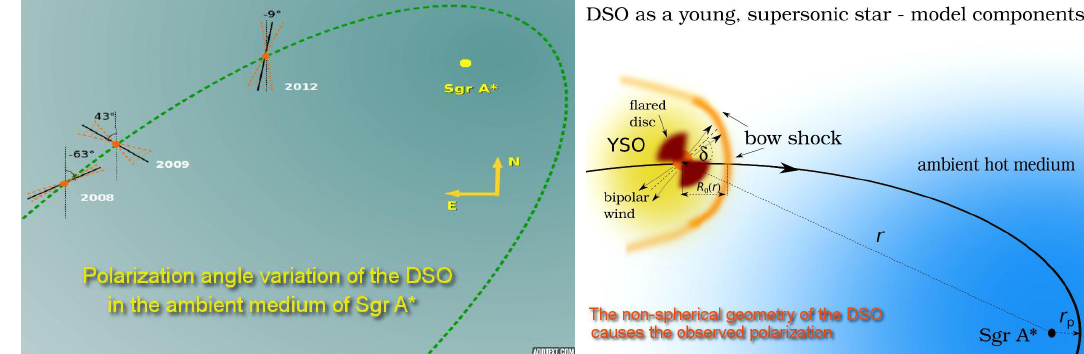
Figure 1. Left : The illustration of the Dusty S-cluster Object (DSO)/G2 polarization angle